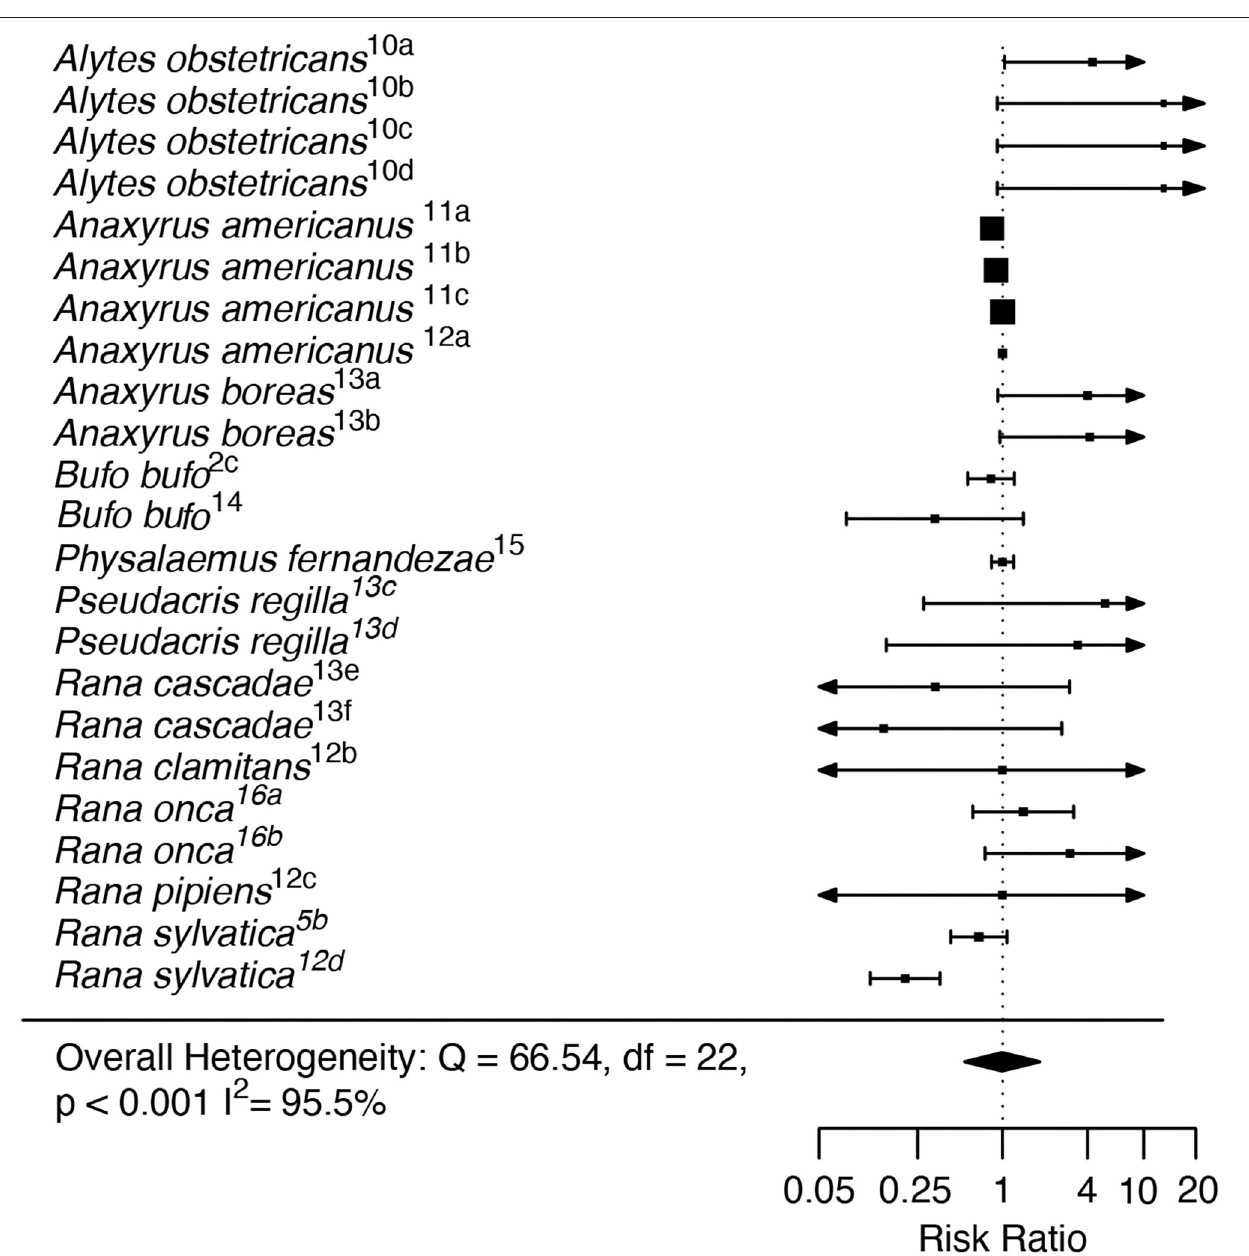
FIGURE 4 | Recent Adaptation analysis forest plot depicting Risk Ratio effect sizes across study units. Squares indicate mean effect size for each study unit, and error bars depict 95% Confidence Interval (CI). The meta-analytic mean effect across all study units (black diamond) was calculated without any moderator terms. Arrows on error bars indicate that the CI exceeds the provided x-axis scale. Study unit ID numbers correspond to Table 1 . Heterogeneity test statistic (Q), degrees of freedom (df), and p -value is reported for Cochran’s Q test of heterogeneity for the overall